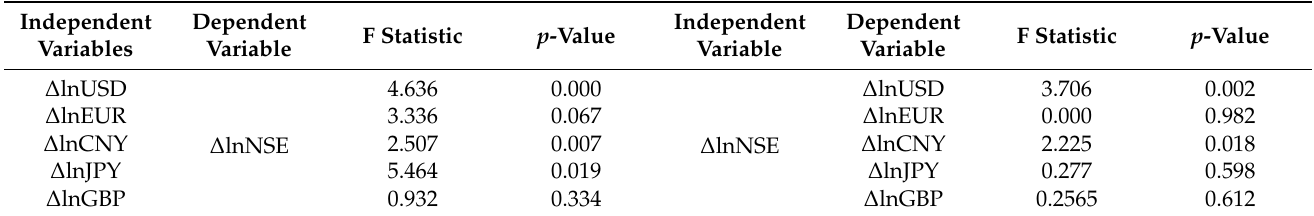
Table 6. Granger causality in VAR Framework for the period November 2013–December